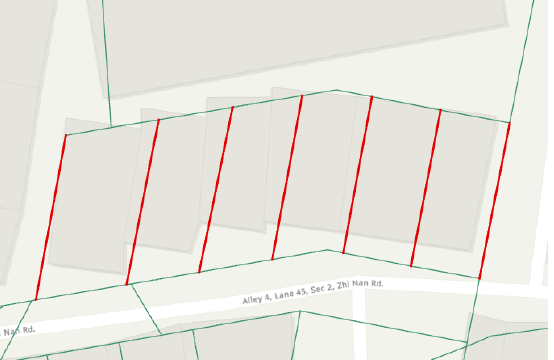
Figure 17. Possible cadastral detail line on the boundary between townhouses.